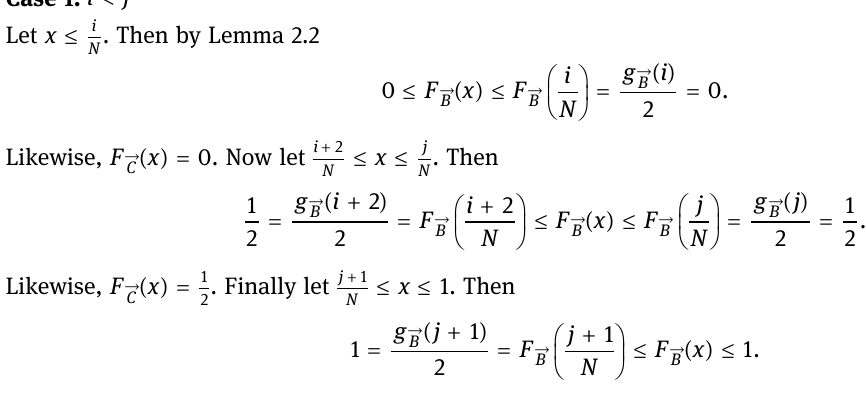
Figure 4: Case 2 – Sketch of piecewise linear approximations of F